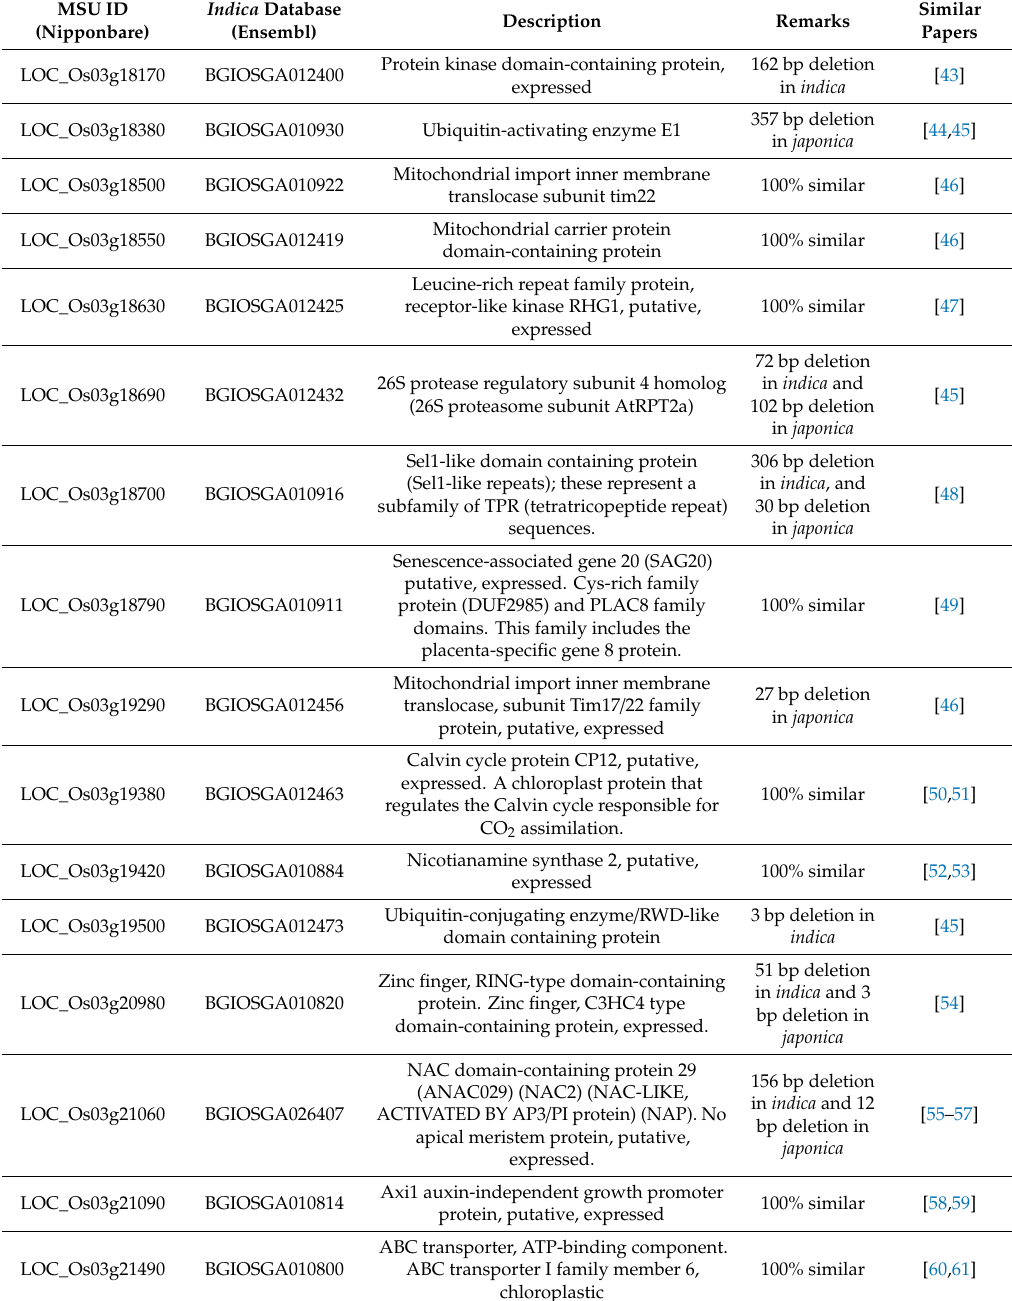
Table 2. List of candidate